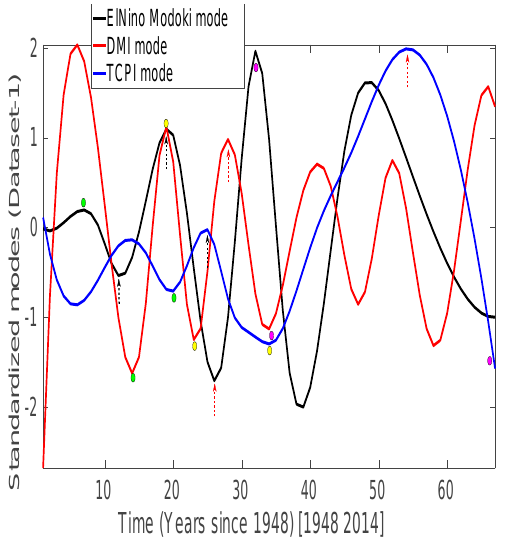
Figure 10. Mode comparison between TCPI, DMI and El Niño Modoki index using Dataset-1. TCPI and DMI are positively related to each other while El Niño Modoki relates negatively to both. A peak in the El Niño Modoki index is associated with the corresponding valleys in the DMI and TCPI modes.